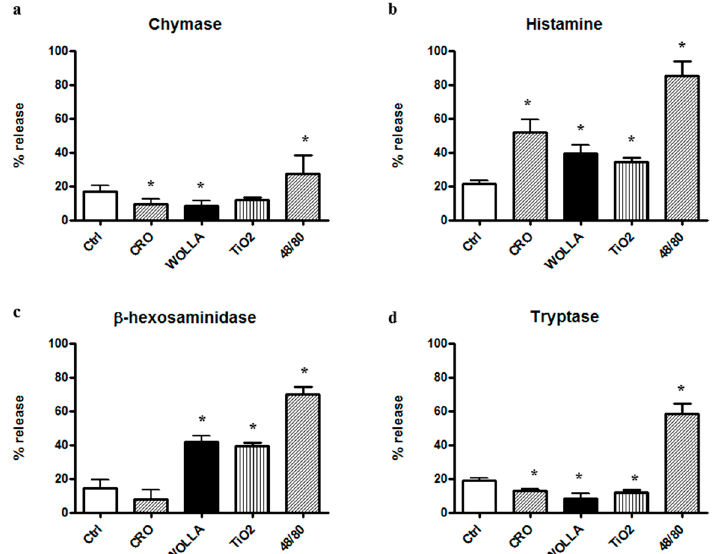
Figure 6. Enzyme secretion from mineral fiber (100 μ g/mL) or 48/80 compound (10 μ g/mL)-stimulated RPMCs. Values are the mean ± SD of at least four different experiments. The extent of secretion, i.e., the percentage of enzyme activity in the supernatant, was calculated taking total enzyme activity (supernatant + pellet) as 100% (mean value ± standard deviation (SD): 0.074 ± 0.006 for chymase, 0.079 ± 0.006 for β -hexosaminidase ( β -hexo) Optical Density (OD)/30 min and 0.060 ± 0.005 OD/30 min for tryptase). In the case of histamine, the total (supernatant + pellet) fluorescence arbitrary units were considered as 100%. See text for details. In the case of β -hexosaminidase, the control value did not differ significantly from that obtained with crocidolite stimulation. In all other cases, the difference between control and stimulated (crocidolite or 48/80) values was significantly different ( p < 0.05) (asterisks). CTRL = control unstimulated cells; Cro = crocidolite-stimulated cells; Wolla = wollastonite-stimulated cells; TiO 2 = TiO 2 NW-stimulated cells; 48/80 = 48/80-stimulated cells.